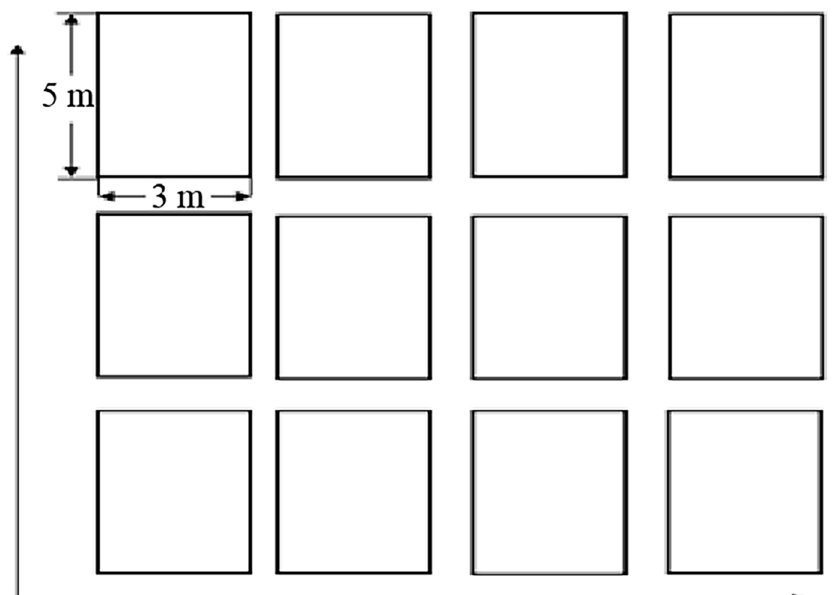
Figure 2. Schematic diagram of sample plot distribution Figure 2 . Schematic diagram of sample plot distribution sampling. Table 1 . Description of seed dressing dose.